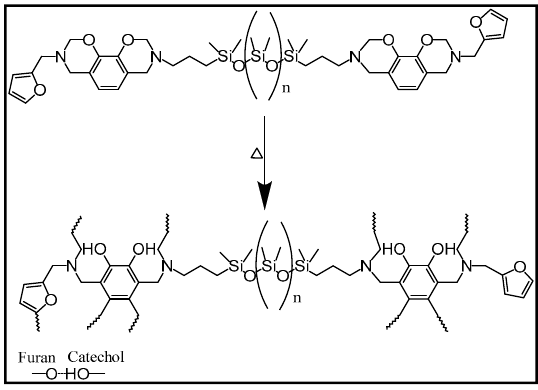
Figure 2. 1 H NMR spectra of CA-pdms-fu in CDCl 3 and its reactants.